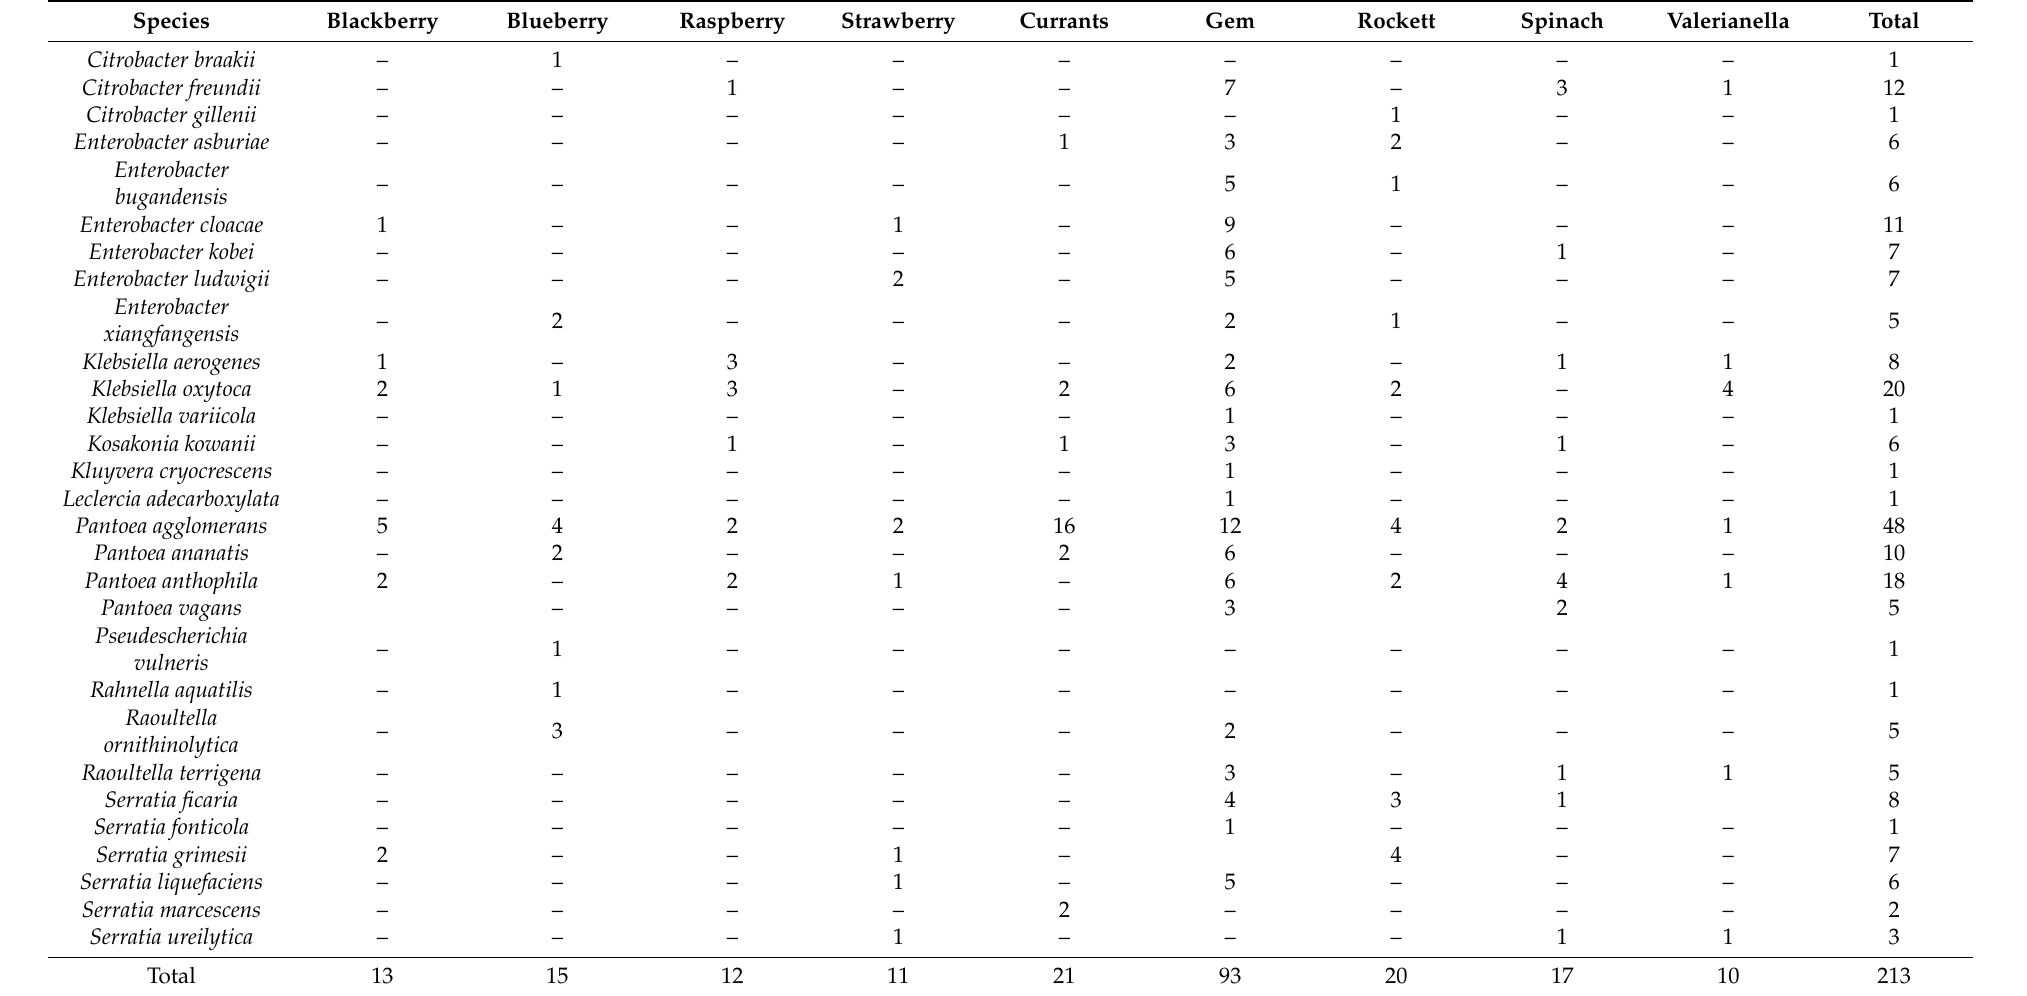
Table 1. Maldi-TOF identification of non-redundant coliform isolates grown from samples of leafy vegetables and berry fruits in VRBL agar. Species Blackberry